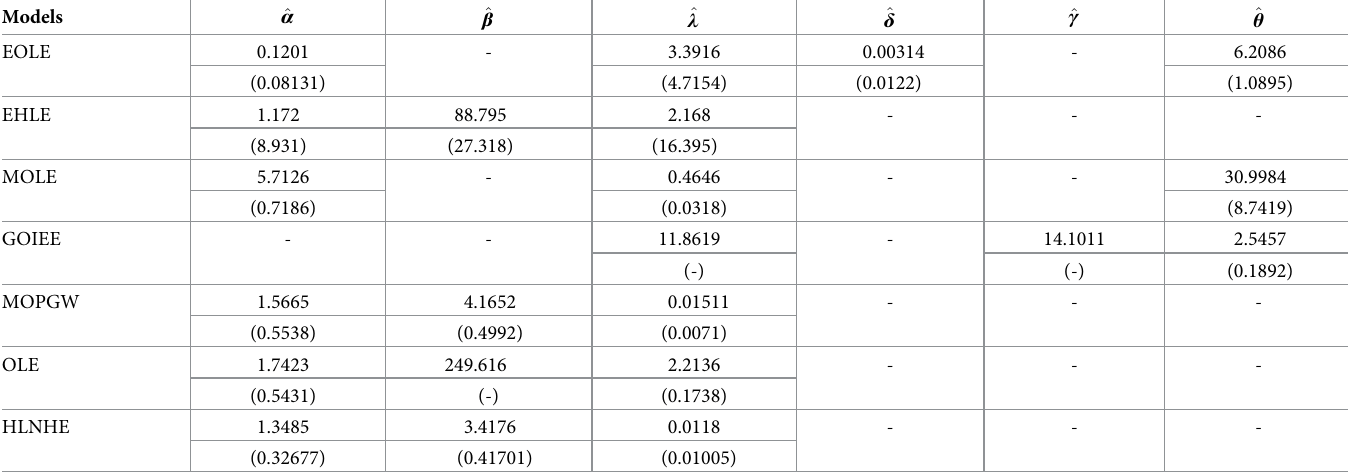
Table 8. Estimated parameter values of all competitive models. Models